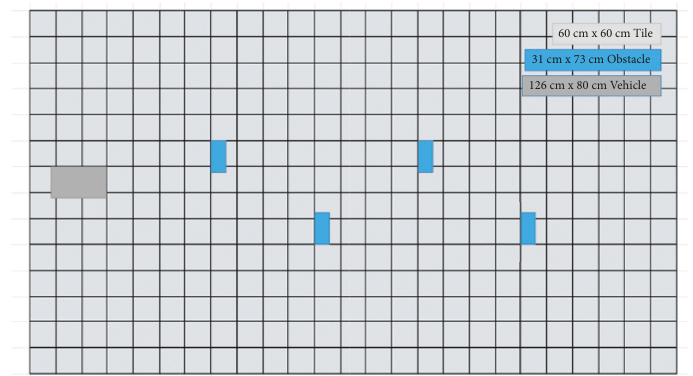
Figure 10: Mobile robot and obstacle settings.